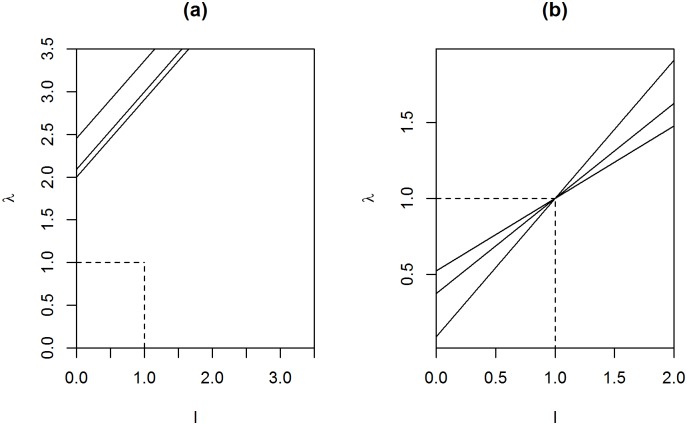
Linear shrinkage of the eigenvalues.Shrinkage of the eigenvalues of the MAP of the covariance matrix, as r is fixed and α changes when n < p (a) and with α = r − p − 1 as the sample size n increases (b). The x-axis denotes the eigenvalues of the MLE (l) and y-axis denotes the corresponding eigenvalues of the posterior estimate (λ = Φ(l)−1).